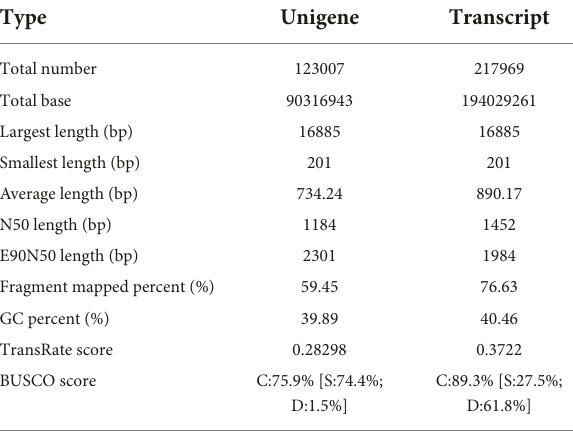
TABLE 1 Evaluation of the assembly result.